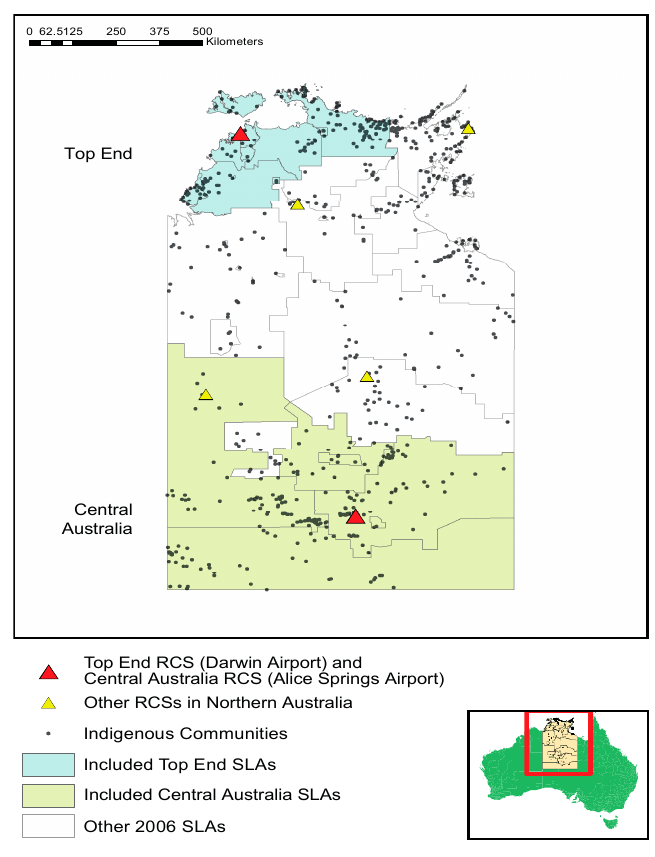
Figure 1. Location of communities, climate zones and Reference Climate Stations (RCS).